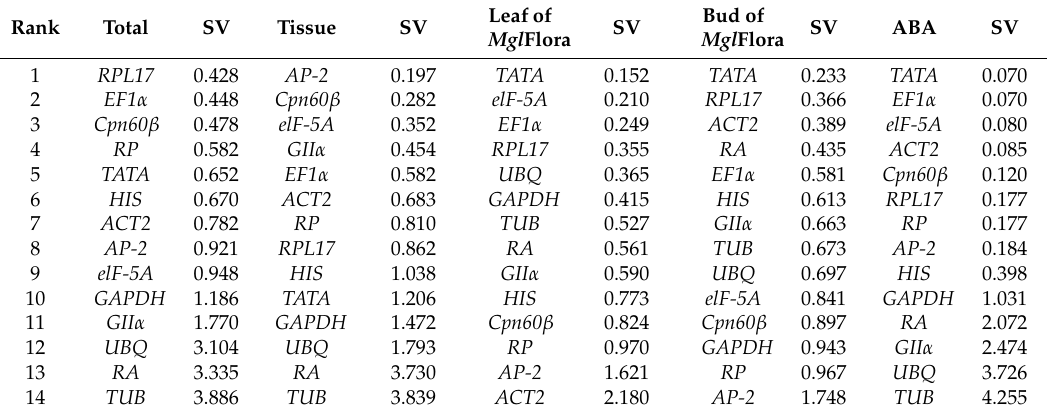
Table 5. NormFinder-based expression stability evaluation of 14 candidate reference